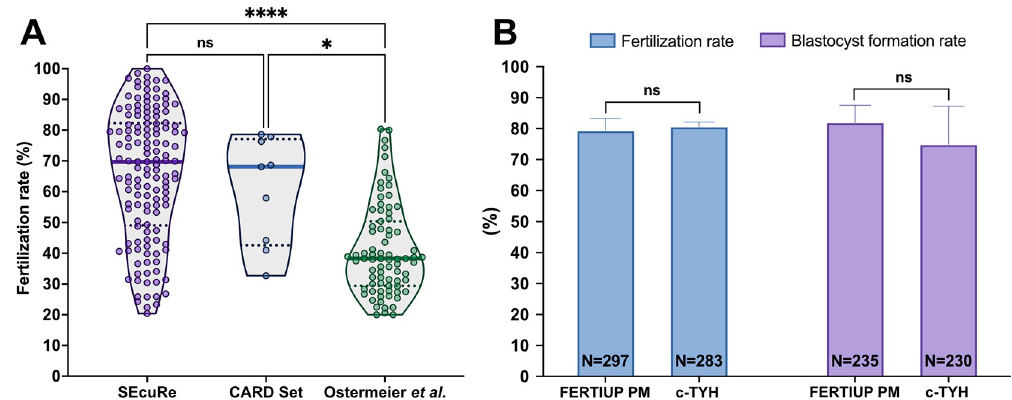
Fig 3. Validation of the SEcuRe protocol. (A) Comparison of the median fertilization rates obtained in the IVF procedures applying the SEcuRe, CARD Set and Ostermeier et al . protocols. Frozen-thawed sperm of C57BL/6 mutant males and oocytes of wild-type C57BL/6N or C57BL/6J females were used for the IVF procedures. Thick lines in the violin plots indicate median fertilization rates and dotted lines the first and the third quartile. Points represent individual experiments (IVF procedures). ���� p < 0.0001; � p = 0.031; ns = non-significant (p > 0.99) (Kruskal–Wallis test). (B) Comparison of the average fertilization rates and blastocyst formation rates in the IVF procedures where either FERTIUP 1 PM or c-TYH was used as a sperm preincubation medium. The data was collected from three independent experiments. Frozen-thawed sperm of wild-type C57BL/6N males and oocytes of wild-type C57BL/6N females were used in these experiments. Data are shown as means ± standard deviation. The blastocyst formation rate shows the percentage of 2-cell embryos obtained in the IVF procedures that reached the blastocyst stage after 72 hours of in vitro culture. N indicates the total number of fertilized oocytes (fertilization rate) or 2-cell stage embryos (blastocyst formation rate). ns = non-significant (p � 0.41) (Student’s t-test).